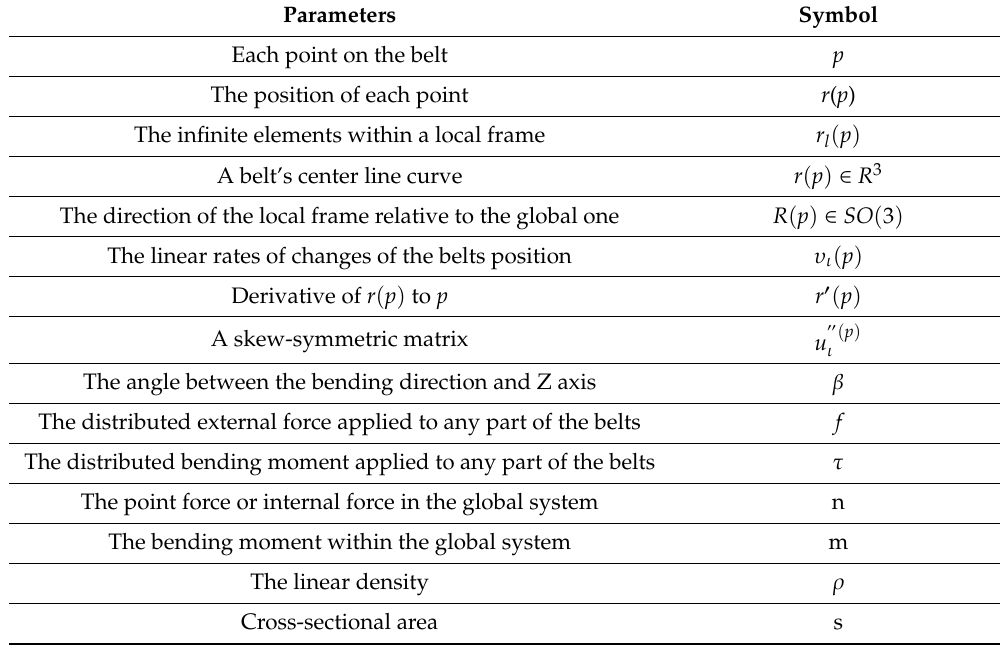
Table 1. Geometric parameters in the Cosserat theory. Parameters Symbol Each point on the belt p The position of each point r ( p ) The infinite elements within a local frame r l ( p ) A belt’s center line curve r ( p ) ∈ R 3 The direction of the local frame relative to the global one R ( p ) ∈ SO ( 3 ) υ ι ( p ) Derivative of r ( p ) to p r (cid:48) ( p ) (cid:48)(cid:48) ( p ) A skew-symmetric matrix u